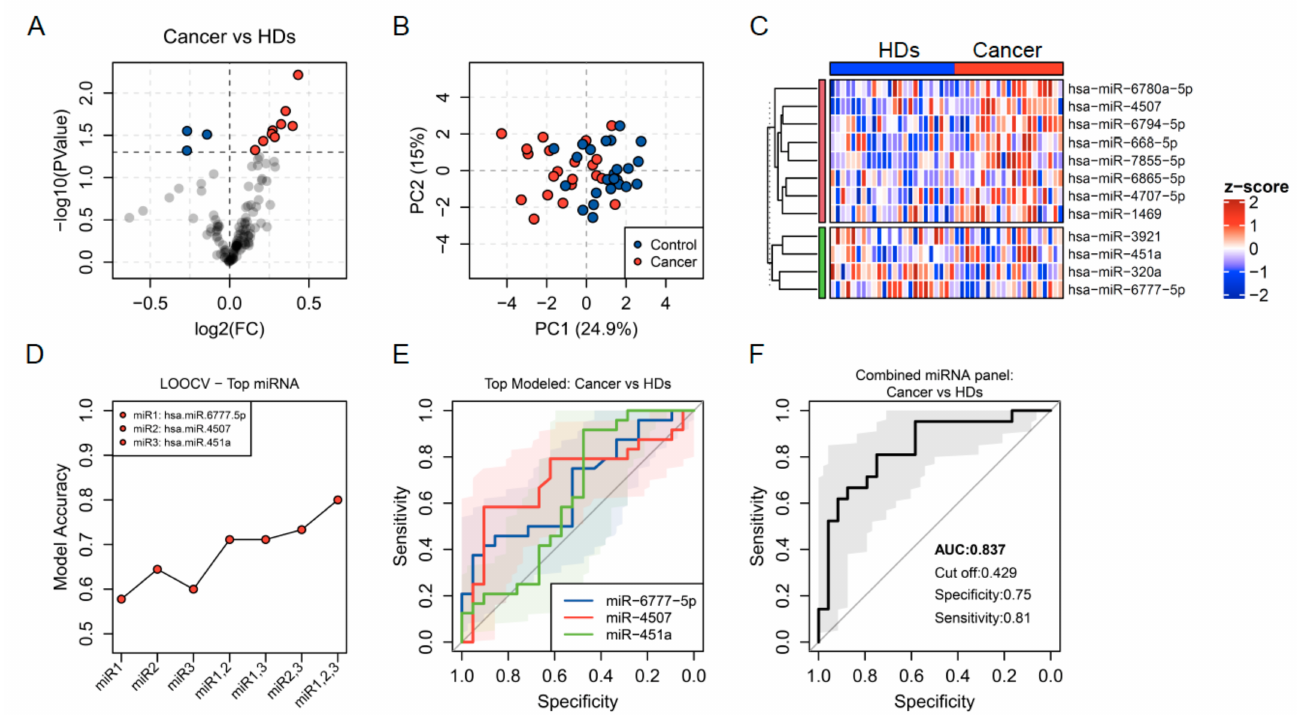
Figure 2. ( A ) Volcano plot showing fold change (FC) and statistical significance of individual miRNA levels in the breath condensate of cancer patients compared to healthy donors. Blue and red dots represent negatively and positively regulated miRNAs respectively ( p < 0.05). ( B ) Regulated miRNAs calculated PCA plots showing the PC1 and PC2 scores for individual cancer patients (red dots) and healthy donors (blue dots). ( C ) Heatmap showing z-score of miRNAs regulated in healthy donors and cancer patients. ( D ) Accuracy of lung cancer prediction calculated by LOOCV models for individual miRNAs and for the four possible combinations. ( E , F ) ROC curves predicted for an individual ( E ) and combined miRNAs ( F ) selected through a random forest iteration